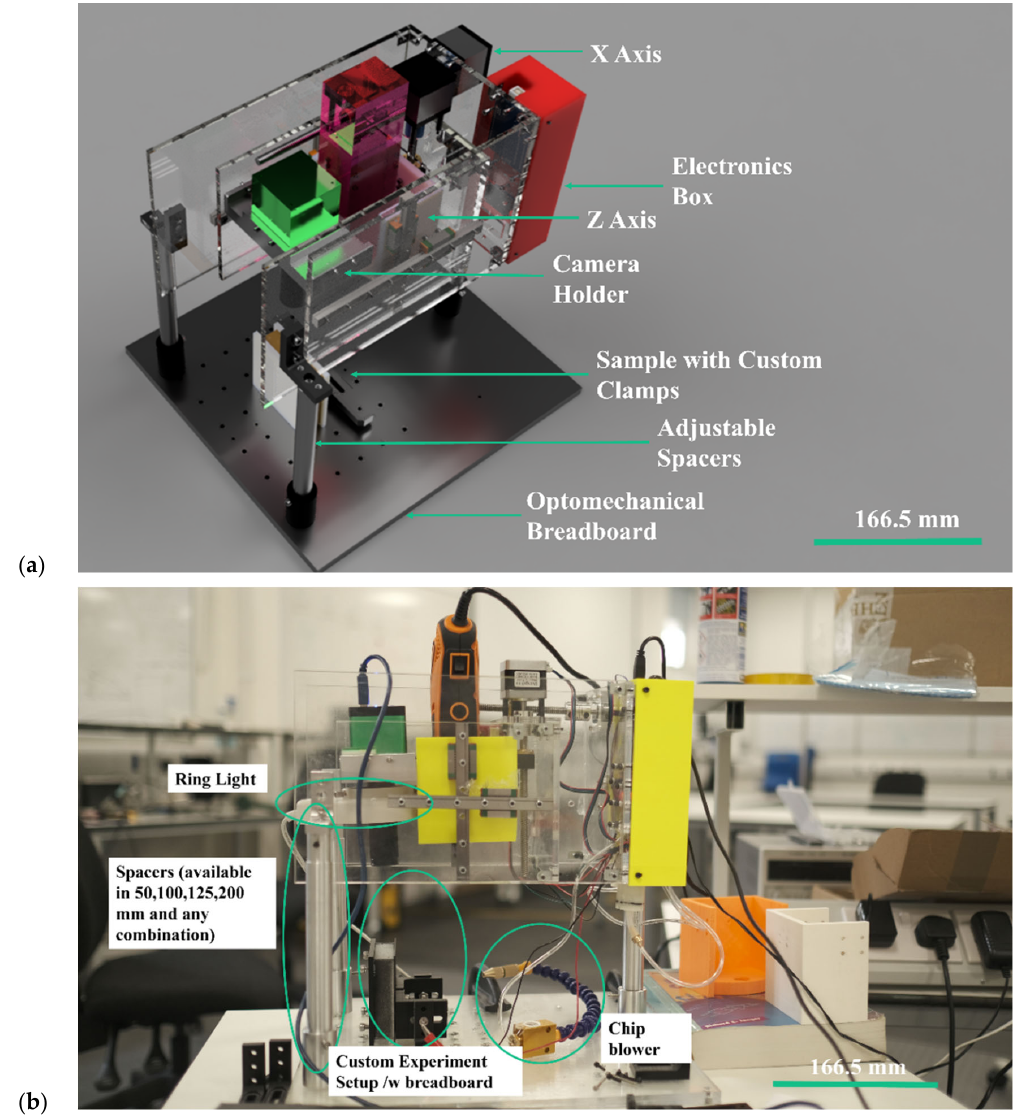
Figure 1. ( a ) CAD representation of the measurement device, with key components highlighted. ( b ) Image of the device with key components highlighted.